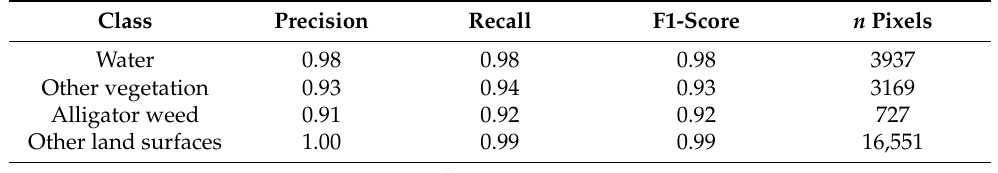
Table 6. Summary of 2016 random forests classifier accuracy metrics.